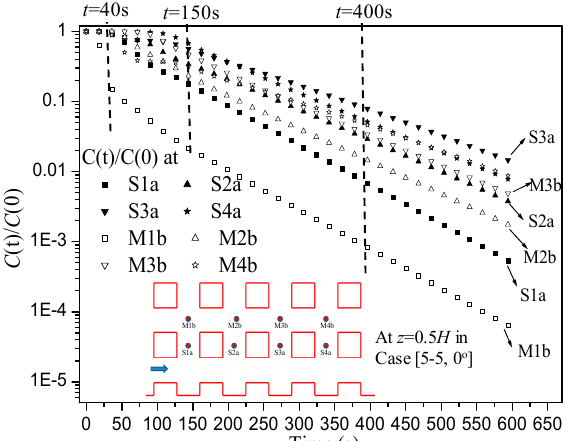
Figure 4. In Case [5-5, 0°] ( θ = 0°): ( a ) 3D streamline and normalized velocity in z = 0.05 H ; ( b ) C ( t )/ C (0) at time of 10 s to 400 s in plane of z = 0.5 H .